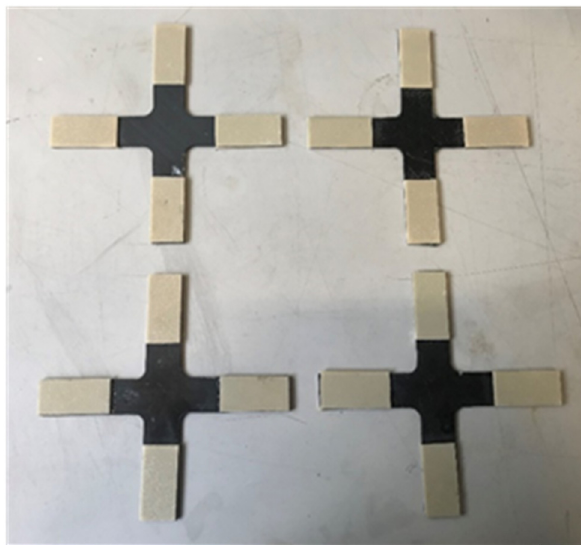
Figure 3: Cruciform samples ready to be tested.